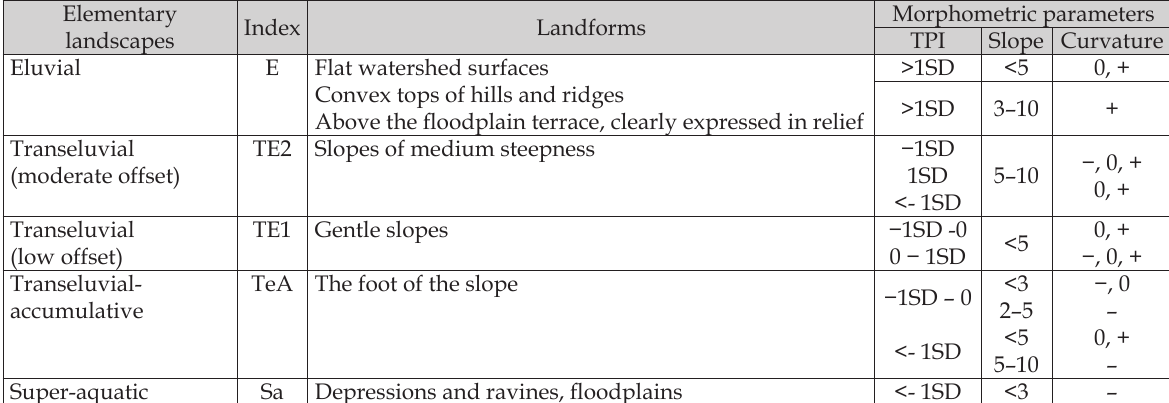
Table 2. Criteria for distinguishing elementary landscapes.